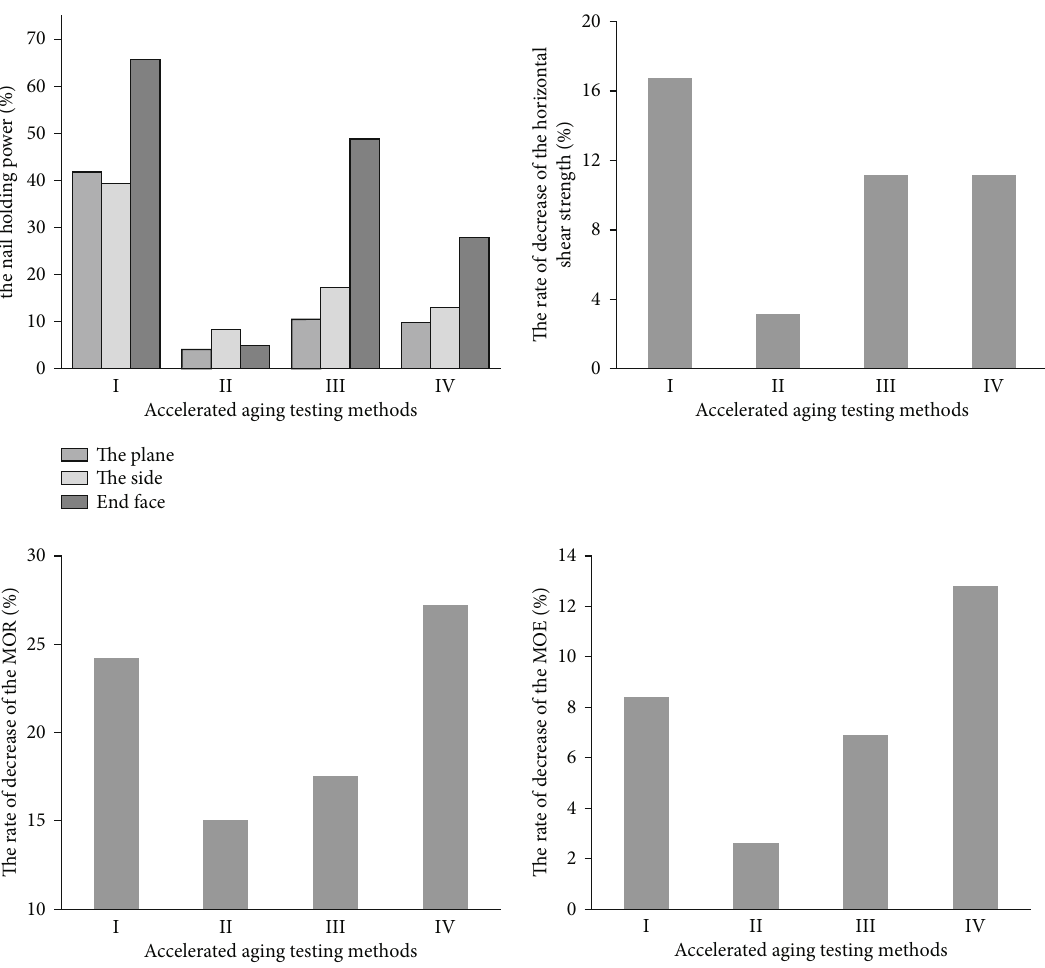
Figure 7: The decrease of mechanical properties of bamboo scrimber after the four accelerated ageing testing treatment